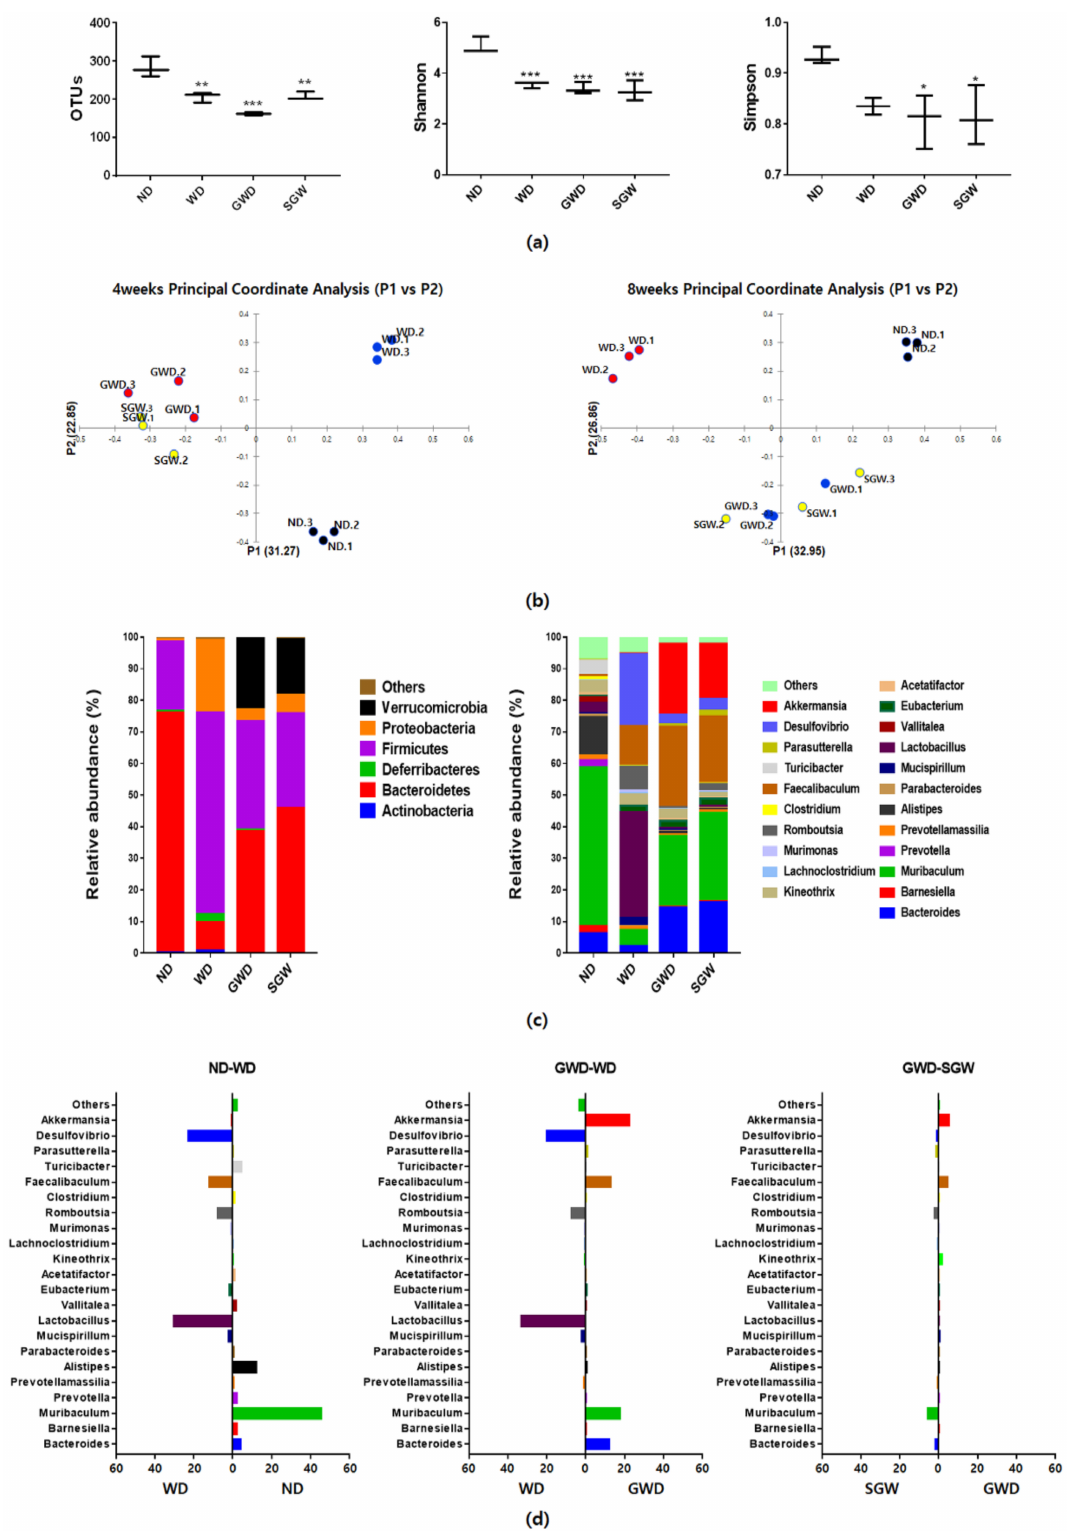
Figure 2. Microbial community analysis of feces samples. ( a ) Operational taxonomic unit levels, Shannon’s and Simpson diversity indices; ( b ) Bray–Curtis dissimilarity-based principal coordinates analysis; ( c ) Relative abundances plot of bacterial phyla and genus; ( d ) Di ff erent abundance of gut microbial composition by diet. Data are presented as the mean ± SEM for three cages per each group (* p < 0.05, ** p < 0.01, *** p < 0.001 vs.